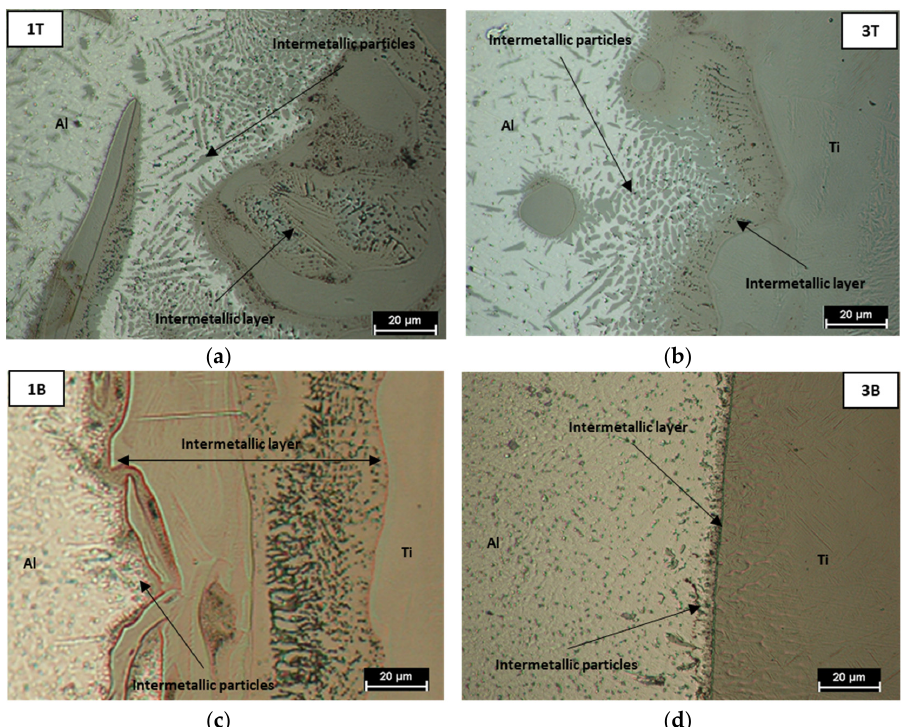
Figure 4. IMCL thickness size for joints 1T and 1B and joints 3T and 3B as function of the focus beam position.